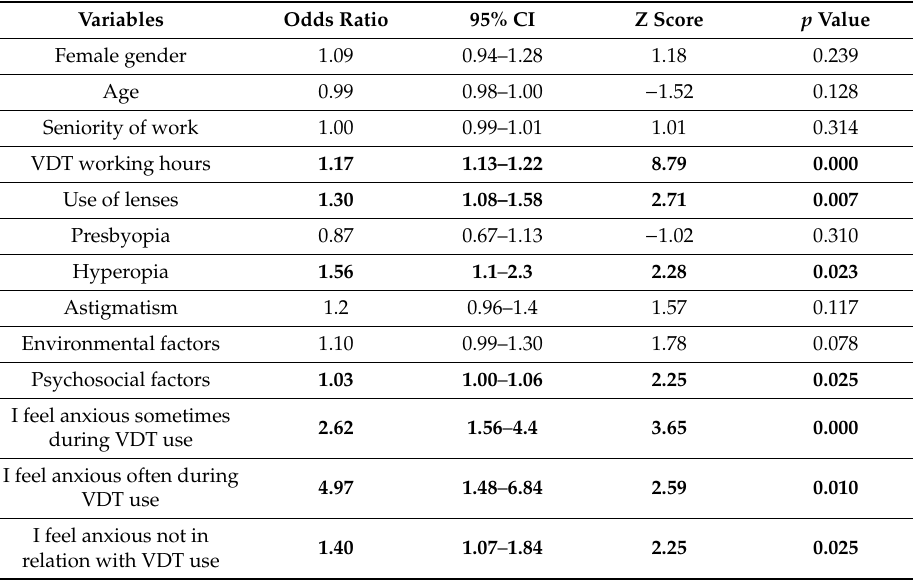
Table 5. Factors associated to visual fatigue in the first examination, evaluated with multivariate logistic regression ( n = 3054